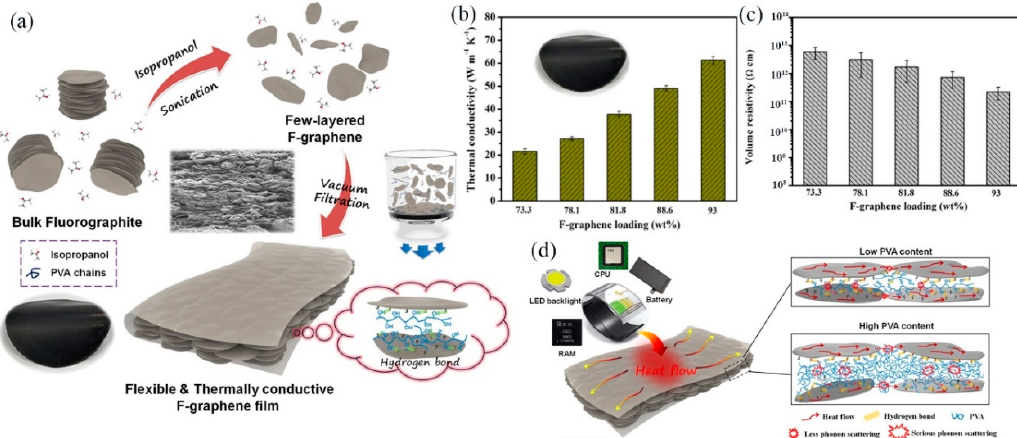
Figure 5. ( a ) Schematic diagram of the exfoliation of fluorinated (F)-graphite and the preparation process of F-graphene composites films. ( b ) The thermal conductivity and ( c ) volume resistivity of F-graphene composites films. ( d ) The heat-conduction mechanism of F-graphene composites films (reproduced with permission from [110]).